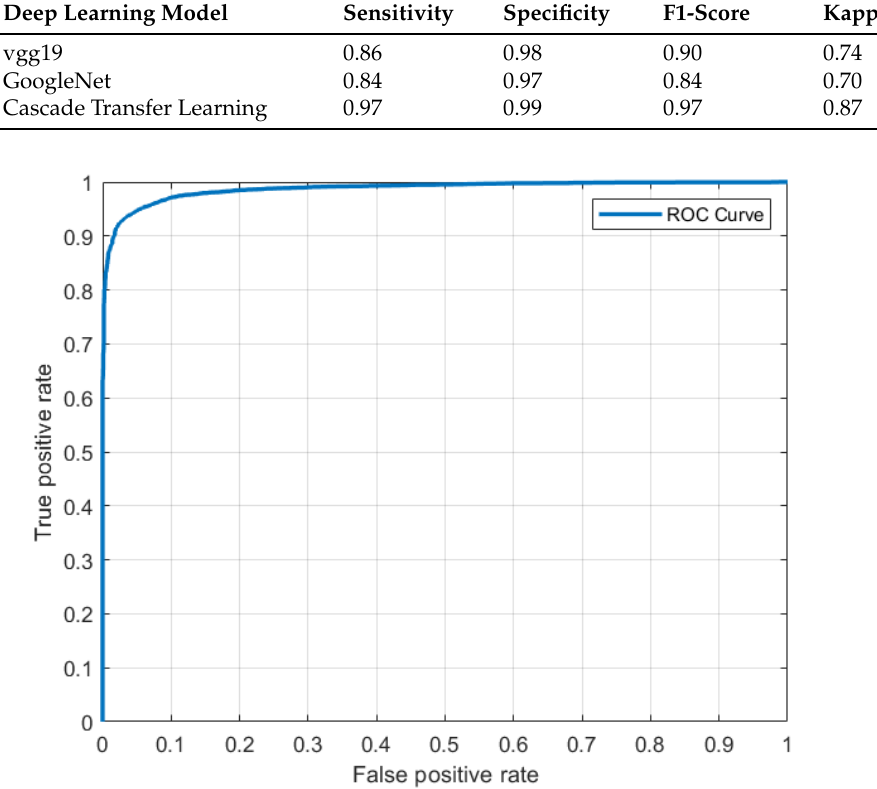
Figure 6. ROC curve of the cascade transfer learning model. The AUC is